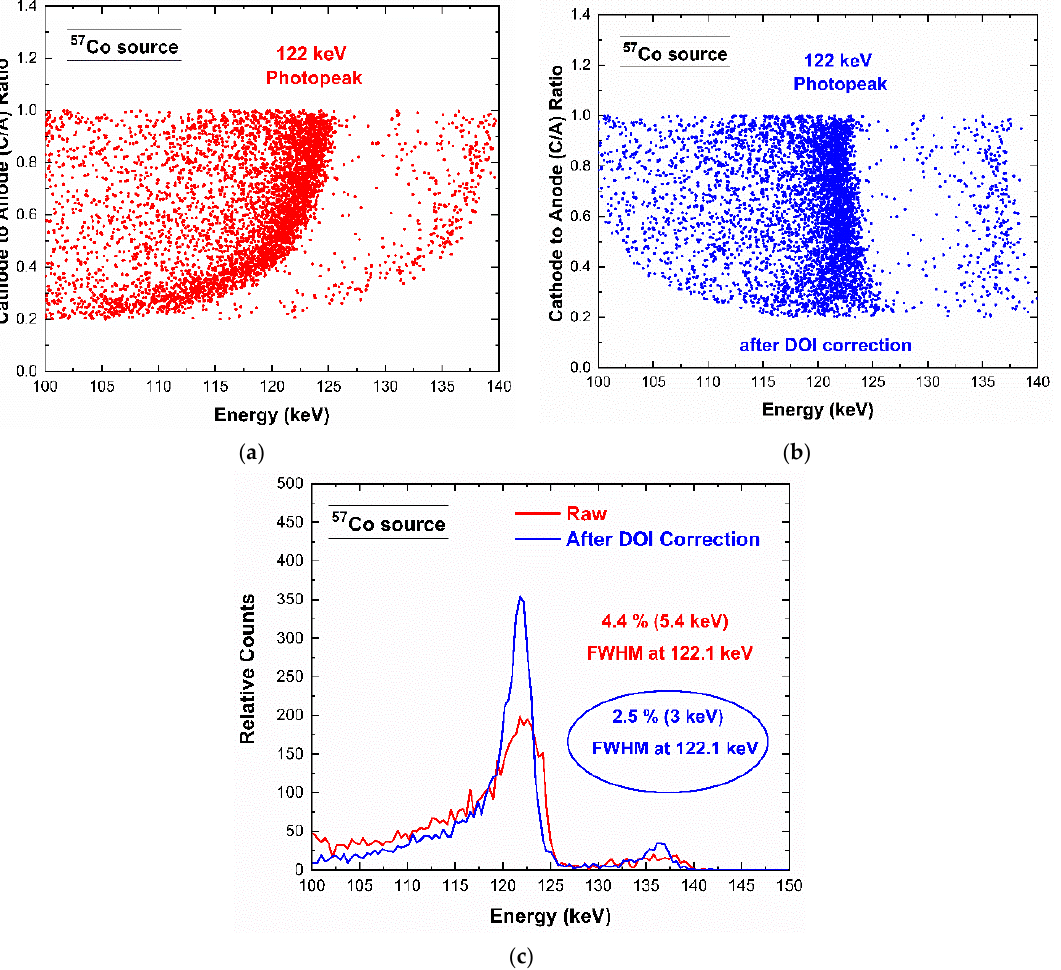
Figure 11. ( a ) Scatter plot of the cathode to anode (C/A) ratio vs. the energy of the anode (pixel). ( b ) The scatter plot after depth of interaction (DOI) correction. ( c ) The raw (red line) and corrected (blue line) energy spectra of the events of the scatter plots. Interesting energy resolution improvements are obtained after the DOI correction.